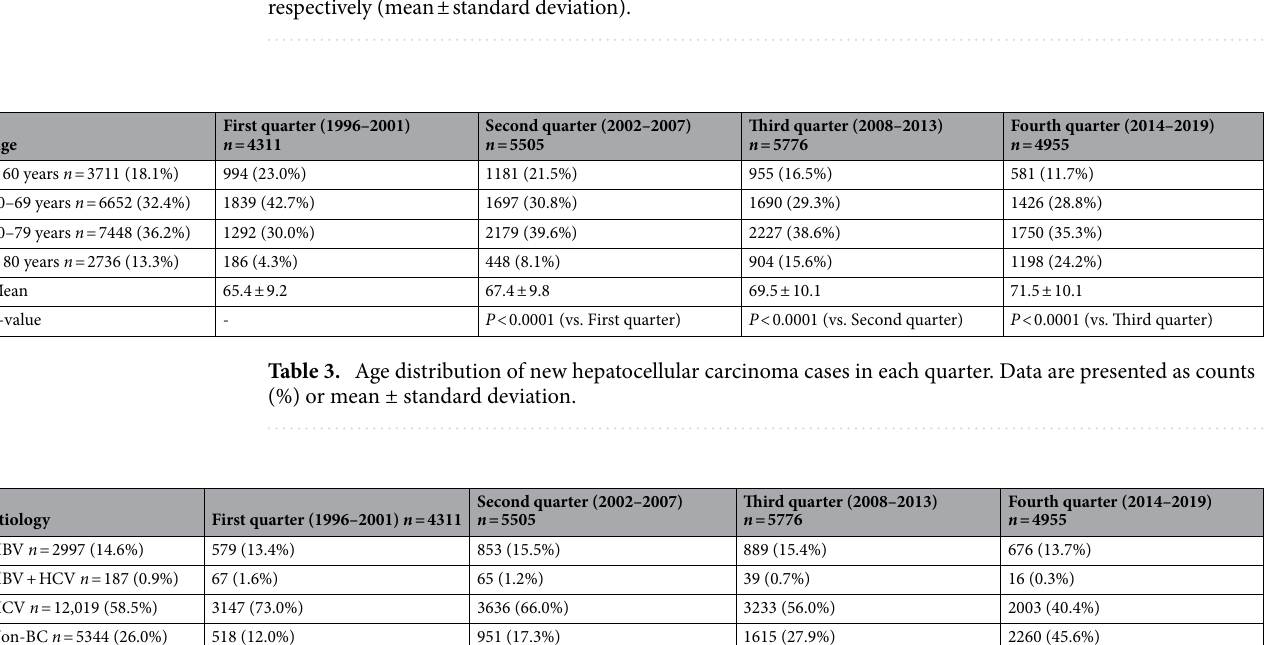
Figure 1. Age distribution of new hepatocellular carcinoma cases. 65.4 ± 9.2 years during 1996–2001 to 67.4 ± 9.8 years during 2002–2007, P < 0.0001; 67.4 ± 9.8 years during 2002–2007 to 69.5 ± 10.1 years during